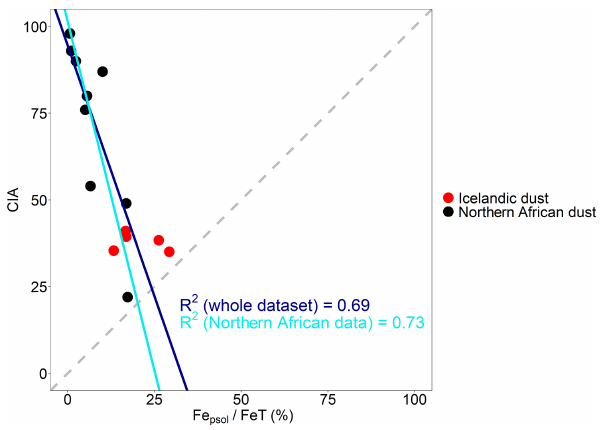
Figure 8. Correlation of the chemical index of alteration (CIA) with Fe psol / FeT (%) performed using the standard major axis regres- sion. The regression line in blue was calculated including the whole dataset: Icelandic dust (this study) and northern African dust (Shi et al., 2011b). The regression line in light blue was calculated using only the northern African dust data (Shi et al.,